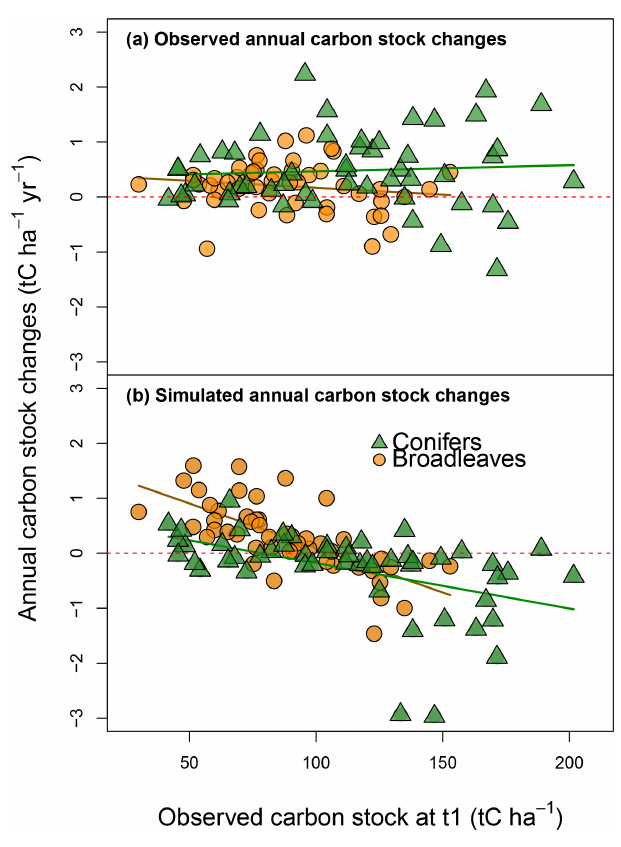
Figure 4. Observed ( y axis; a ) and simulated annual changes in carbon stocks ( y axis; b ) plotted against the CSs observed to 1.0m in depth ( x axis) during the first soil CS assessment. Regressions are as follows: y = − 0 . 003 x + 0 . 422 ( R 2 = 0 . 03) for observed val- ues at the sites dominated by broadleaves, y = 0 . 001 x + 0 . 353 ( R 2 = 0 . 01) for observed values at the sites dominated by conifers, y = − 0 . 016 x + 1 . 715 ( R 2 = 0 . 62) for simulated values for the sites dominated by broadleaves and y = − 0 . 008 x + 0 . 648 ( R 2 = 0 . 60) for simulated values for the sites dominated by